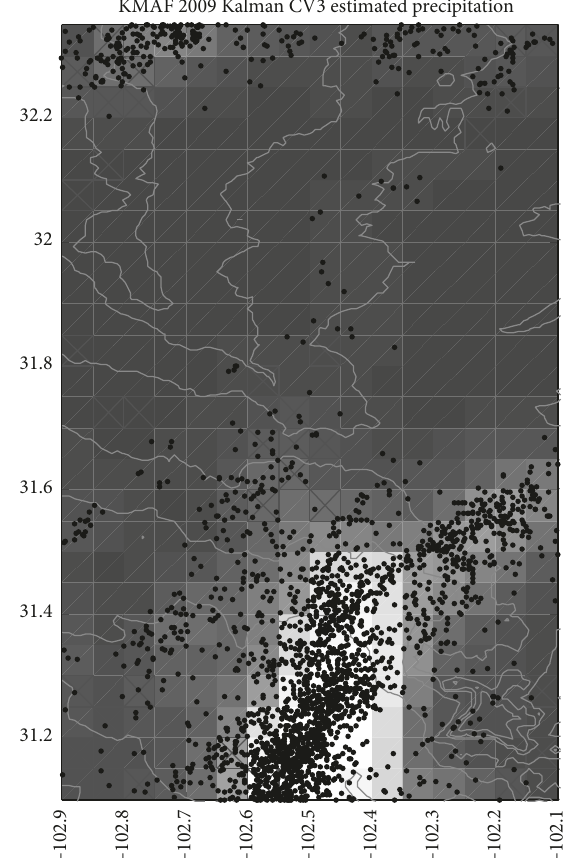
Figure 1: Convective storm in Midland, Texas, lightning-QPE correlation example, from